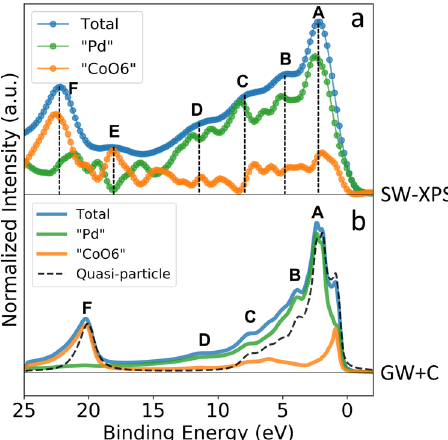
Fig. 4 Experimental and computational valence band structure of Pd and CoO 2 layers. a Layer-resolved valence band contributions of PdCoO 2 extracted from standing wave X-ray photoemission spectroscopy; b Layer- resolved valence band structure calculated by using GW + cumulant theory. The dashed lines indicate the positions of the peaks in the experimental valence band